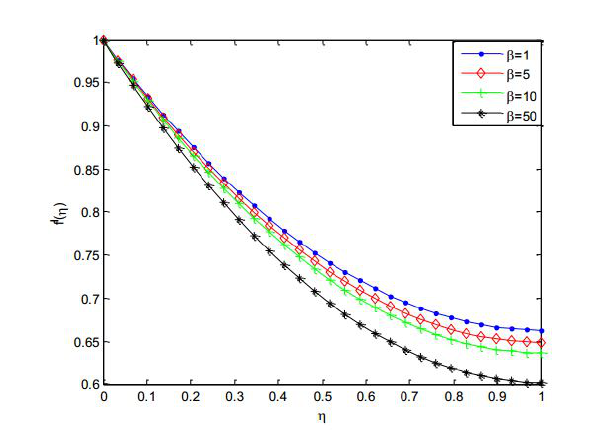
Figure 4. Effects of Casson parameter on the velocity profile of Ag-Kerosene Casson-Carreau nanofluid